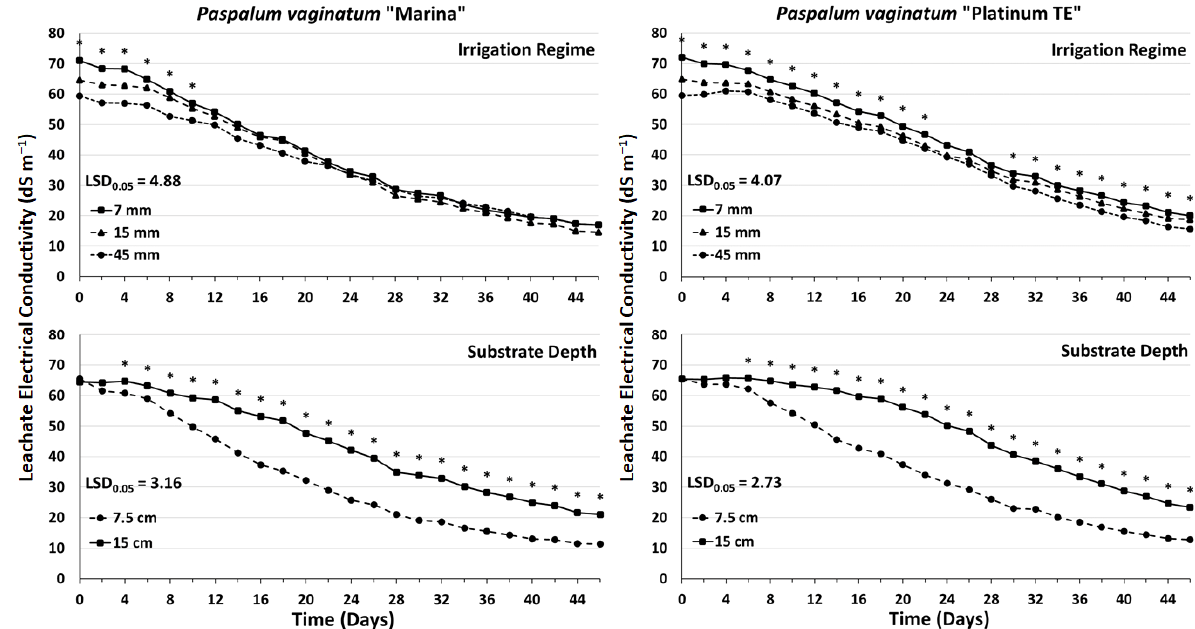
Figure 6. Leachate electrical conductivity (dS m − 1 ) of the two Paspalum vaginatum varieties “Marina” and “Platinum TE” during the recovery period using 7 mm irrigation with potable water every other day (15 September–31 October 2016), as affected by seawater irrigation regimes during the salinity stress period (7 mm, 15 mm, or 45 mm) and green roof substrate depth (7.5 cm or 15 cm). Values are the mean of 4 replications. Asterisks (*) indicate significant differences in-between treatment means on a single sampling date, according to Fisher’s least significant difference (LSD) at p < 0.05 following the repeated measures model.